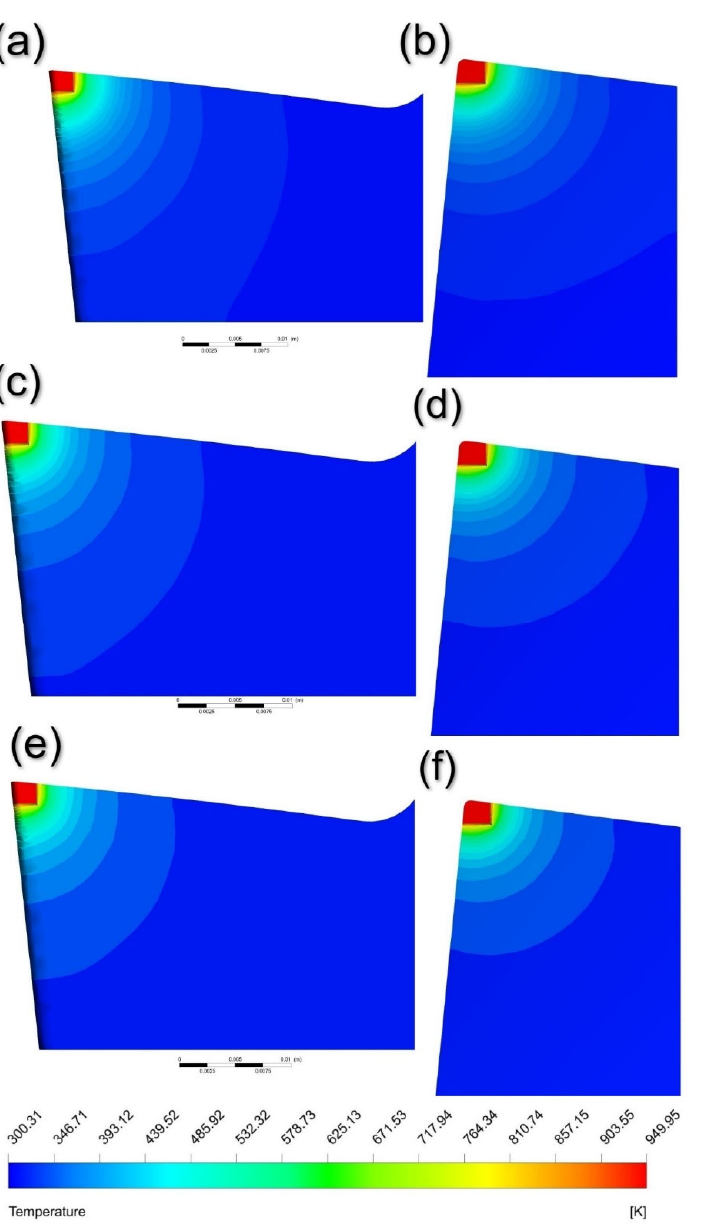
Figure 10. Temperature distribution of the cutting tool on ( a ) Al 2 O 3 —Flank Face, ( b ) Al 2 O 3 —Rake Face, ( c ) Al—Flank Face, ( d ) Al—Rake Face, ( e ) SWCNT—Flank Face and ( f ) SWCNT—Rake